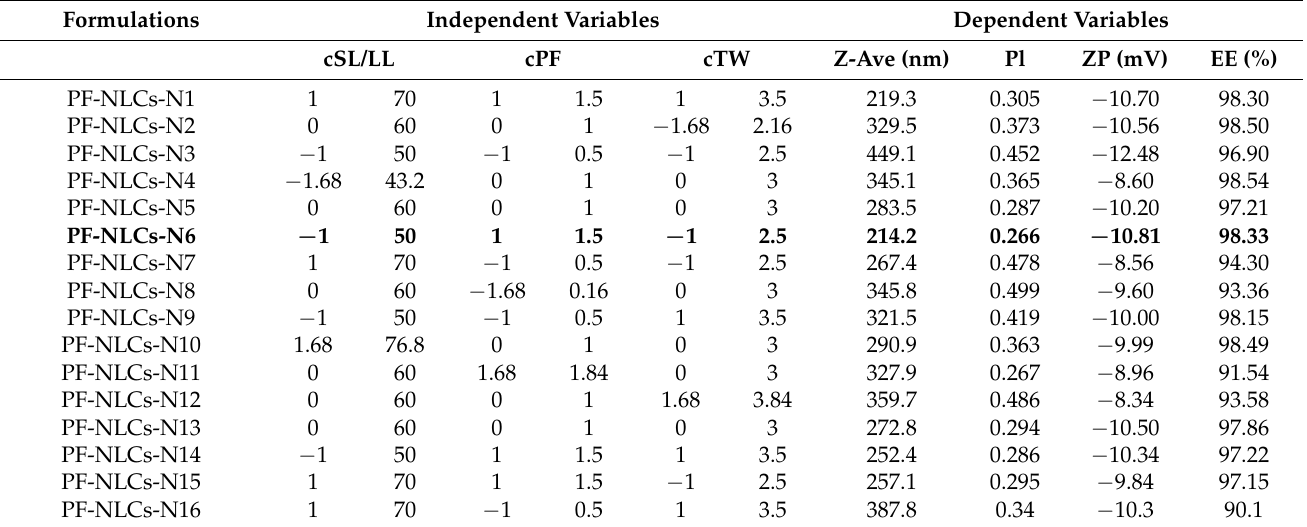
Table 4. Independent and dependent variables of the 2 3 start central composite rotatable factorial design